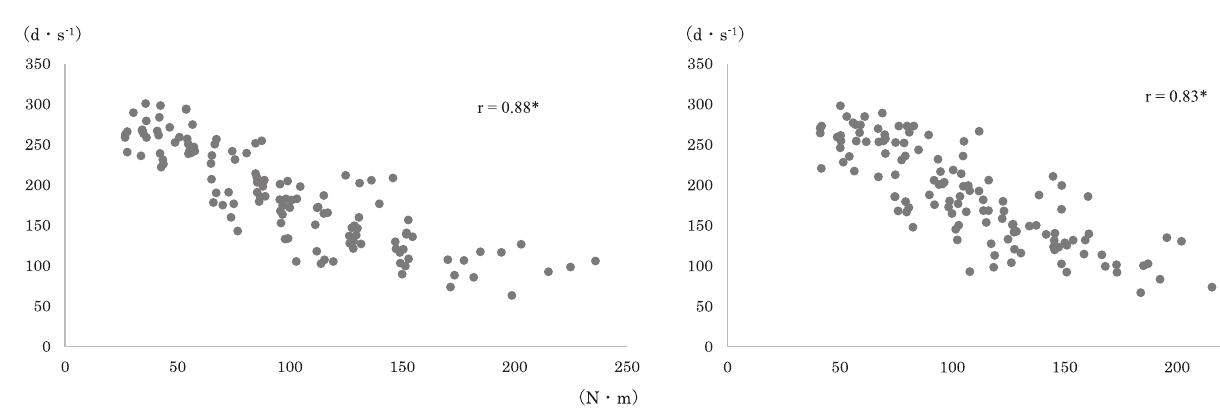
Figure 8 Correlation coefficient between angular velocity and maximum torque after modification of the leg extension machine.